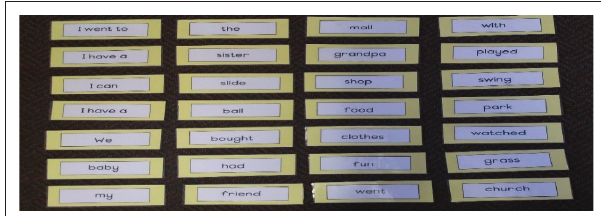
FIGURE 2: Flashcards for Grade 1 learners’ creative writing.